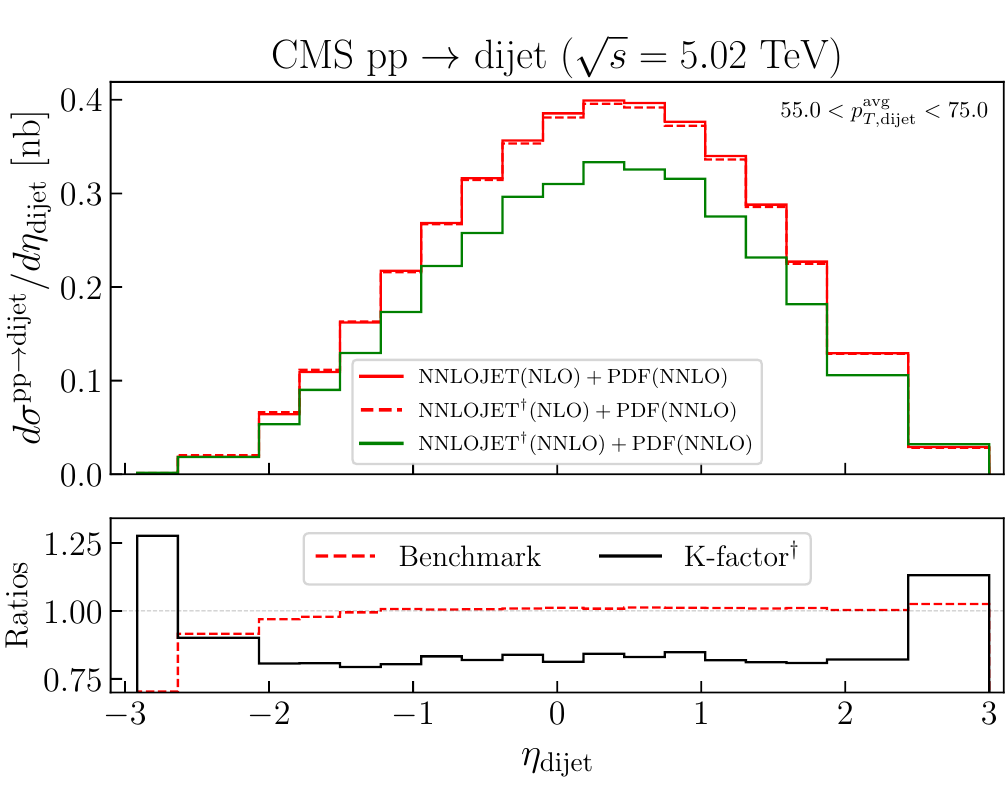
Figure 1: The QCD calculations of the lowest p avg bin of the 5 TeV pp dijet spectra T ,dijet from the CMS data set. The NLO calculations (solid red histogram) and the refer- ence NLO (dashed red histogram) and NNLO (solid green histogram) calculations using NNLOJET in the upper-panel. The ratio of NLO calculation to the reference ones (dashed red histogram) and NNLO QCD K-factors (solid black histogram). The dagger (†) refers to any calculations performed by our co-authors in Ref. [ 2 ]